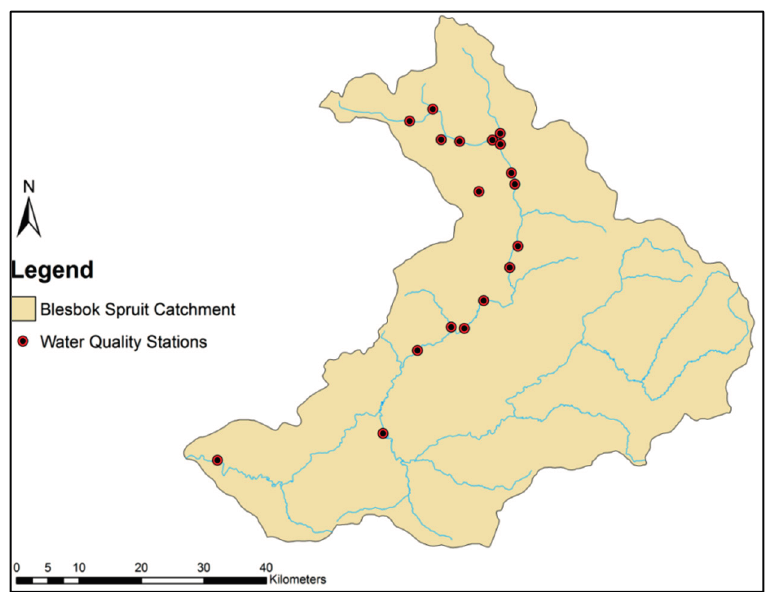
Figure 2. All the available Rand Water quality sampling stations used within the Blesbok Spruit